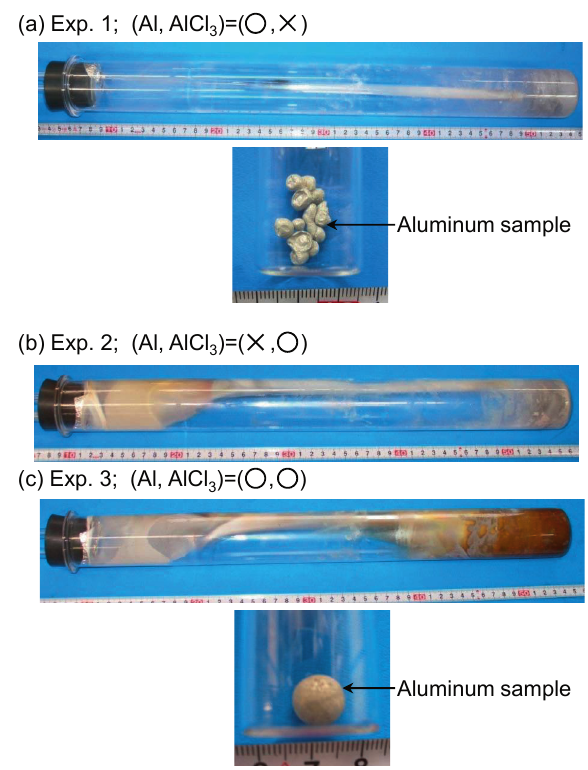
Figure 5. Photographs of the reaction tubes and aluminum samples in the carbon crucible after the reaction for (a) Exp. 1, (b) Exp. 2, and (c) Exp.